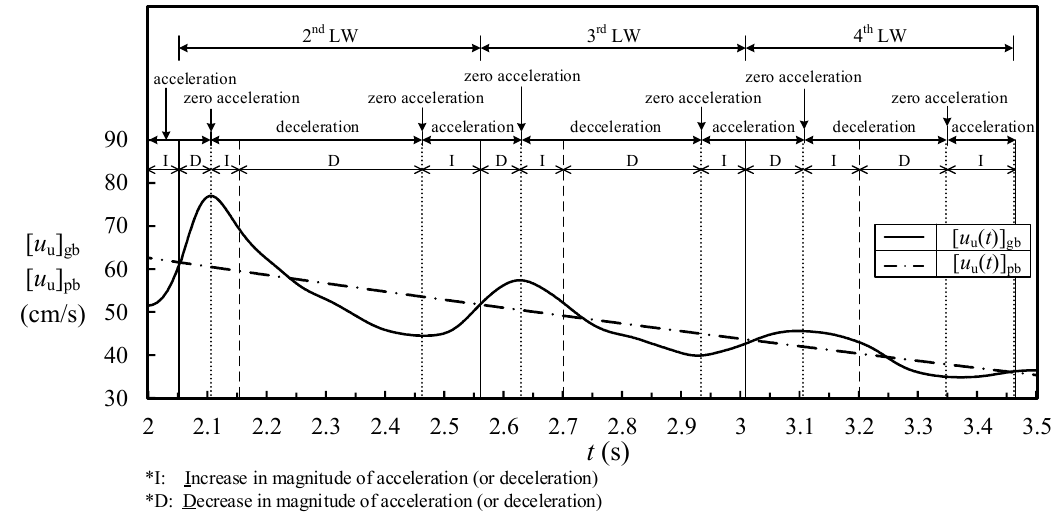
Figure 9. Schematic diagram of variation in acceleration or deceleration in uniform horizontal velocity of the generated bore.